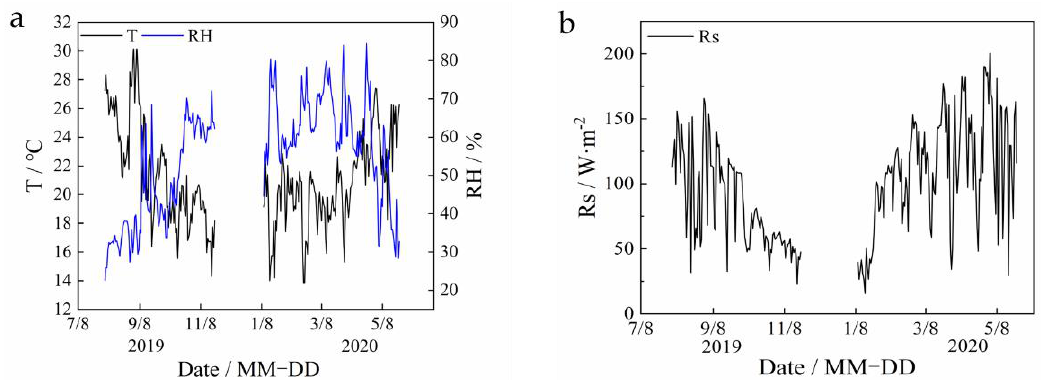
Figure 3. ( a ) Average daily air temperature ( T ), and relative humidity ( RH ), and ( b ) total radiation ( Rs ), during whole tomato growth period from 2019 to 2020.